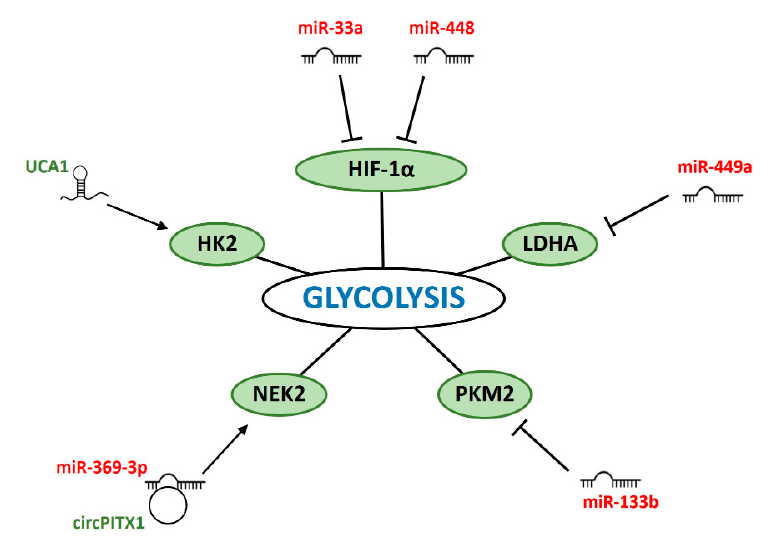
Figure 5. ncRNAs regulating IR-induced glycolysis. ncRNAs promoting (green) or inhibiting (red) glycolysis.